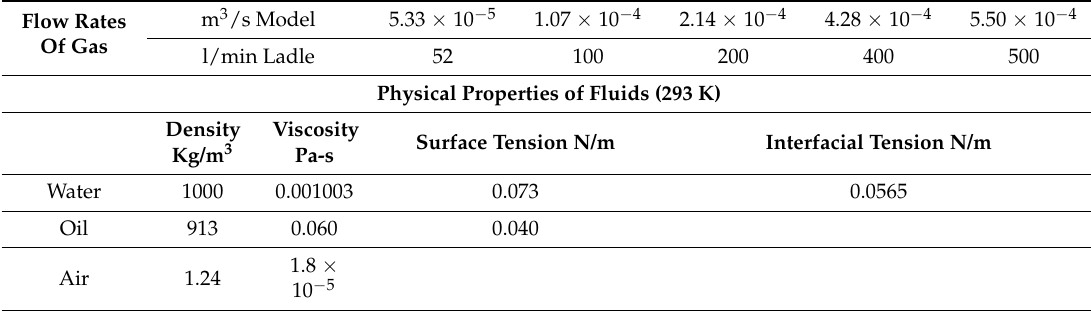
Figure 2. Experimental set up. ( a ) Air compressor. ( b ) Water. ( c ) Oil layer. ( d ) Tracer injection. ( e ) Flat chamber. ( f ) Upper camera. ( g ) Ultrasonic transducer. ( h ) Mass flowmeter. ( i ) Frontal camera. ( j ) Colorimeter cell. ( k ) Air injection. Table 4. Experimental conditions and physical properties of the multiphase model.